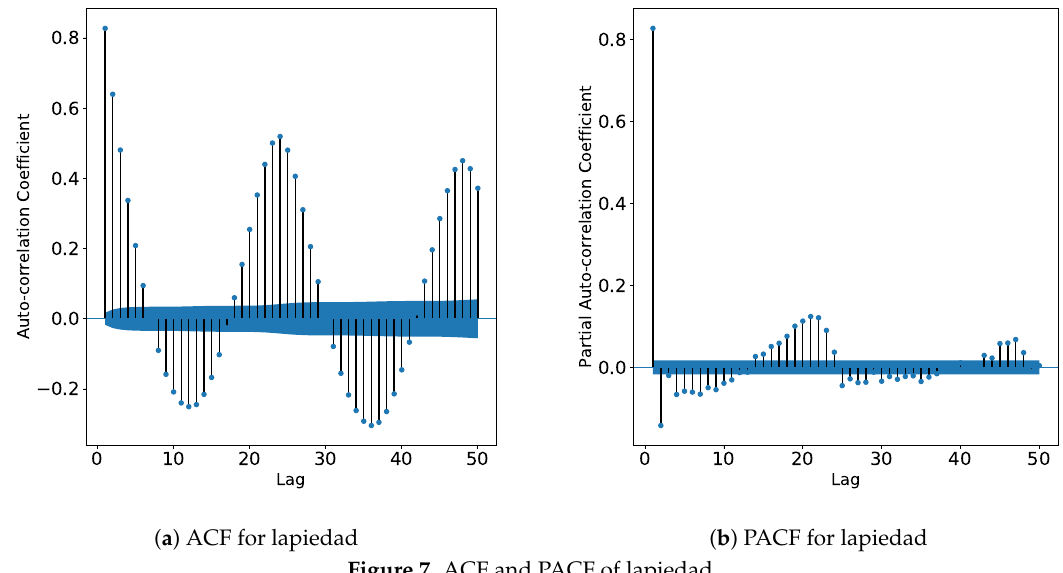
Figure 7. ACF and PACF of